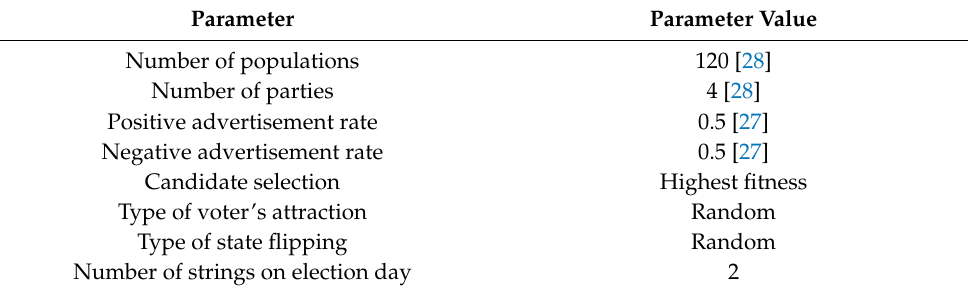
Table 4. List of EA parameters used in training